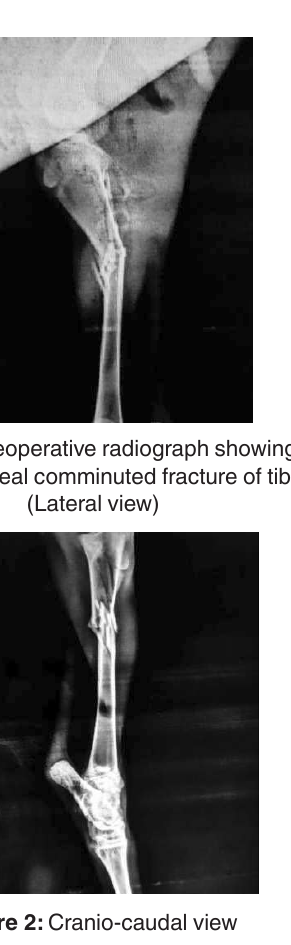
Figure 2: Cranio-caudal